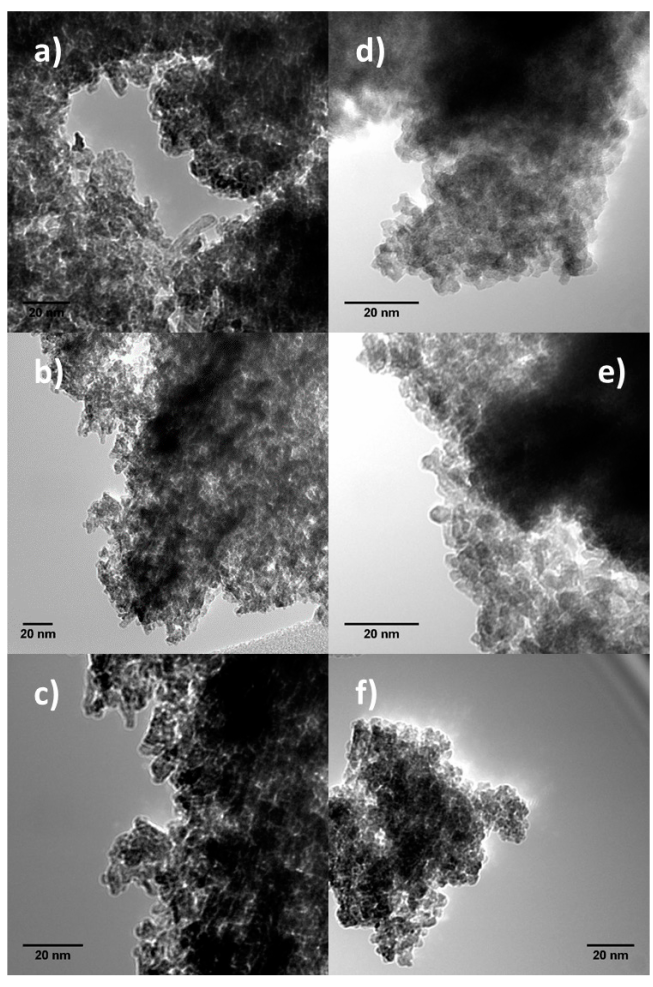
Figure 2. TEM image of control CeO 2 sample: 1 M ( a – c ) and 3 M ( d – f